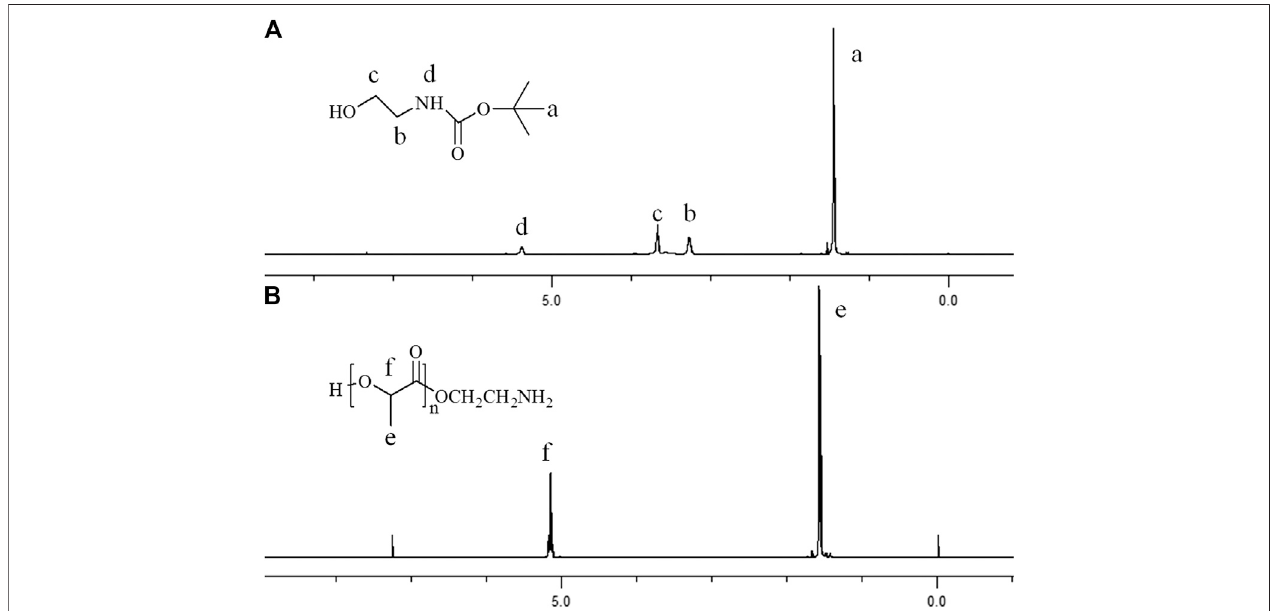
Figure 1 | Proton nuclear magnetic resonance spectra (in CDC 13 , ppm) of (A) EABoc, (B) poly(L-lactide).